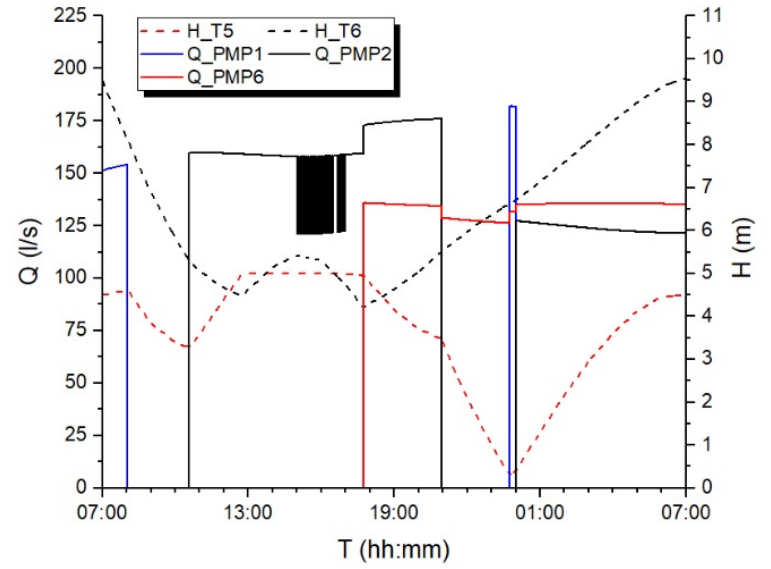
Figure 5. Results of the pump scheduling methodology by [10] for Van Zyl network, hydraulic time-step 10 s.